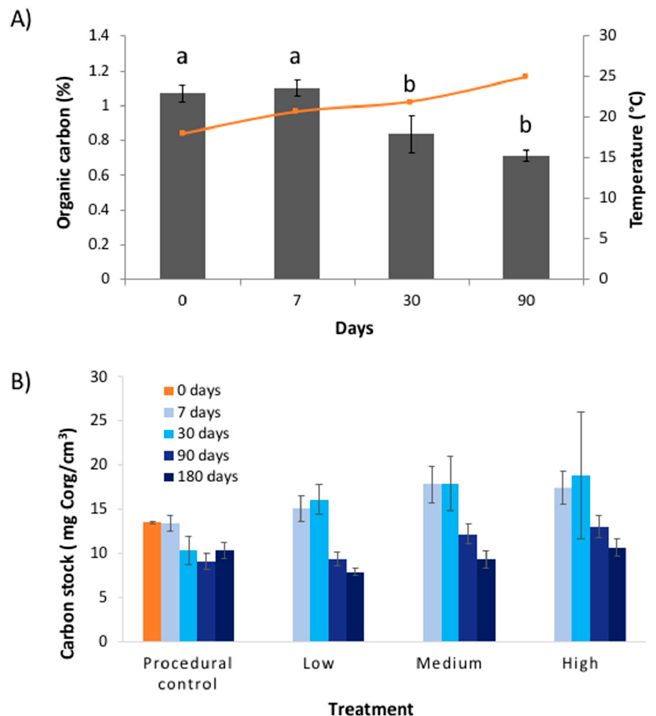
Figure 4. Results (mean ± SE) of experimental warming study showing: ( A ) change in the percentage organic carbon (all treatments pooled) within seagrass soil cores against time (‘days’), overlayed with temperature (orange line); and ( B ) change in carbon stocks for the different treatments and times. Letters above bars in ( A ) indicate differences according to Tukey HSD test.